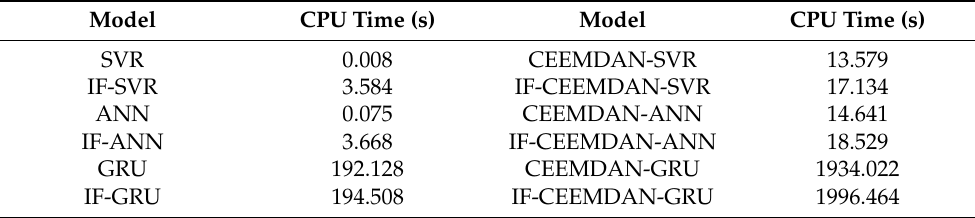
Table 2. Comparison of CPU time for different